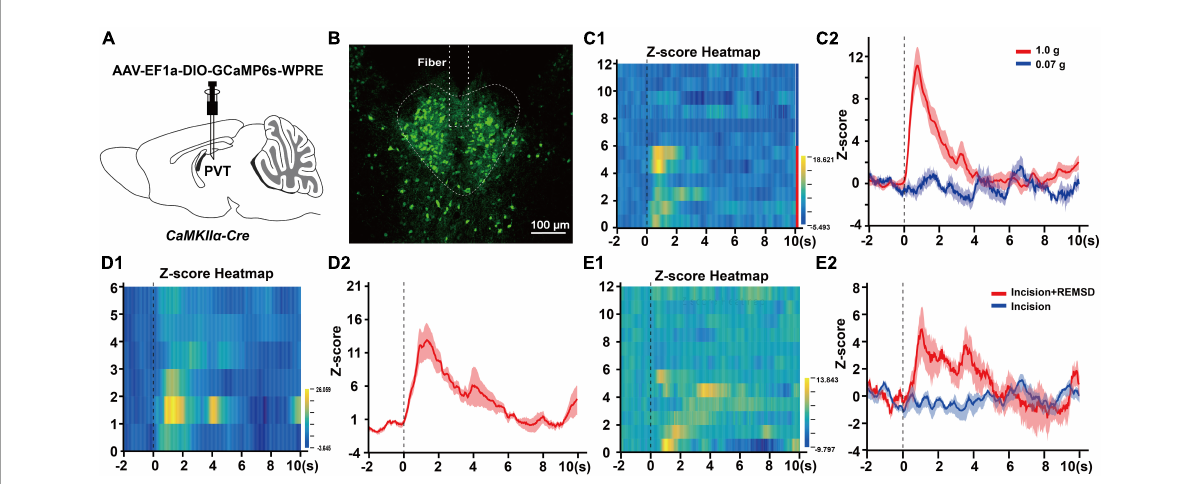
FIGURE3 Noxious stimuli increase mPVT CaMKII α neuronal excitability. (A) Experimental configuration showing AAV-EF1a-DIO-GCaMP6s-WPRE injection into the middle paraventricular thalamus (mPVT) of CaMKII α -Cre mice, and implantation of an optic fiber. (B) The injection site of the virus and the location of the optic fiber in the paraventricular thalamus (PVT). Scale bar: 100 µ m. (C1) Heatmap illustrating the Ca 2 + transients signals of the mPVT CaMKII α neurons in the normal mice receiving von Frey filament stimulation. Each row of the heat map stands for one trial of one mouse, the Y-axis stands for the number of tested mice. Mouse 1 to 6 received the 1.0 g von Frey filament stimulation and mouse 7–12 received the 0.07 g von Frey filament stimulation. (C2) The average Ca 2 + transients of mice shown in panel (C1) . (D1) Heatmap illustrating the Ca 2 + transients signals of the mPVT CaMKII α neurons in the normal mice received acetone stimulation. (D2) The average Ca 2 + transients of mice in panel (D1) . (E1) Heatmap illustrating the Ca 2 + transients signals of the mPVT CaMKII α neurons in the mice received 0.07 g von Frey filament stimulation on the 7th day after surgery. The row 1–6 from the incision + REMSD group and the row 7–12 from the incision group. (E2) The average Ca 2 + transients of the incision and incision + REMSD group mice receiving 0.07 g von Frey filament